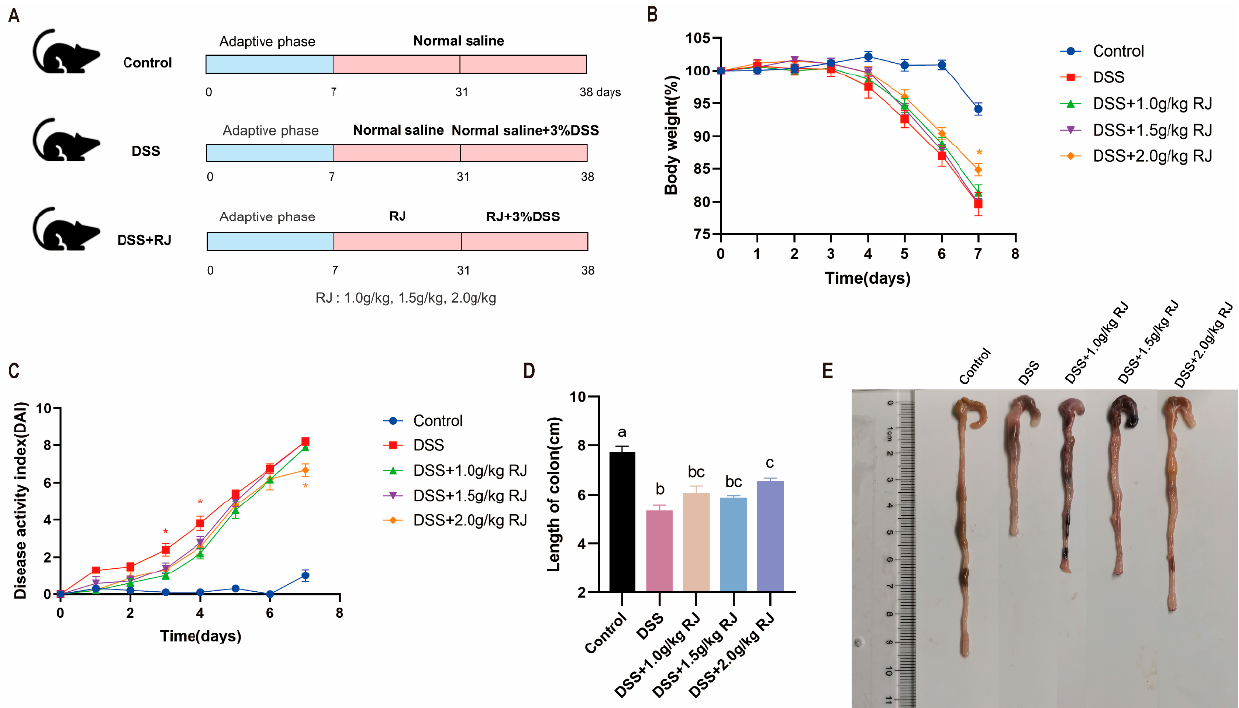
Figure 1. Oral administration of royal jelly improved the symptoms of DSS-induced ulcerative colitis in mice. ( A ) Experimental treatment and grouping; ( B ) weight loss ( n = 8 for DSS + 2.0 g/kg RJ group, n = 10 for other groups); ( C ) disease activity index score changes; ( D , E ) colon length ( n = 8). A dose of 3% w/v DSS drinking water was given on day 31, which was recorded as day 0. Data were expressed as mean ± standard error (SEM). “ * ” means p < 0.05, and there is significant difference between the two groups. The groups marked with different letters had significant differences. The red asterisk (*) indicates that the DSS group was significantly different from the RJ treatment group, and the yellow asterisk (*) indicates that the DSS + 2.0 g/kg RJ group was significantly different from the DSS group.